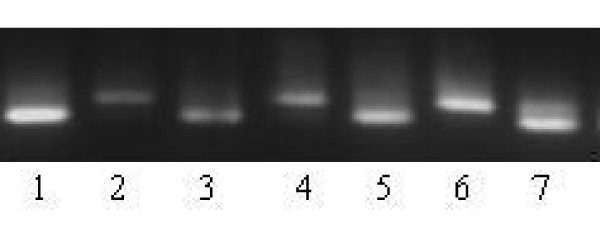
Agarose gel electrophoresis showing the genotypes of RAAS gene polymorphisms. Llane 1, 3 and 5 represents homozygous AA genotypes, lane 2, 4 and 6 represents homozygous GG genotypes and lane 7 shows the heterozygous AG genotypes of A6G polymorphism of AGT gene.